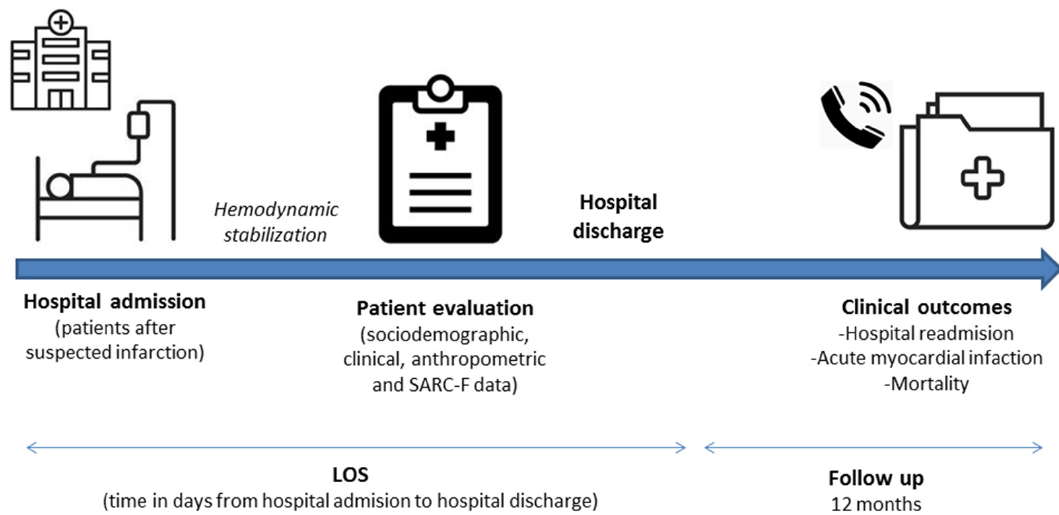
Figure 1. Steps of data collection. Abbreviation: LOS, length of hospital stay.